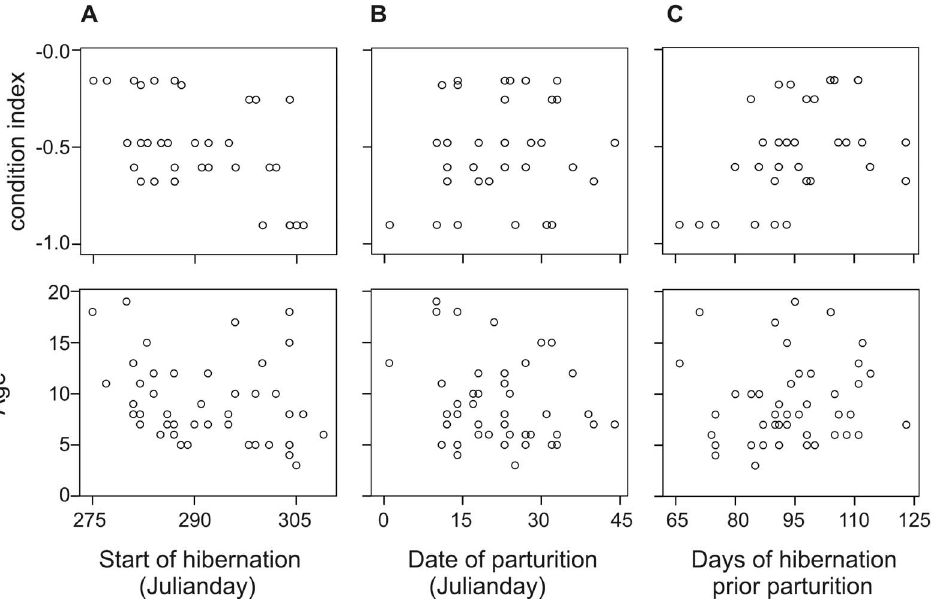
Figure 5. The effect of age and environmental conditions on the start of hibernation (A), date of parturition (B) and on the days of hibernation prior parturition (C) for 46 hibernating pregnant female brown bear in Sweden. The environmental condition index was significant related to the start of hibernation, date of parturition and on days of hibernation prior parturition. Age was significantly related only to the start of